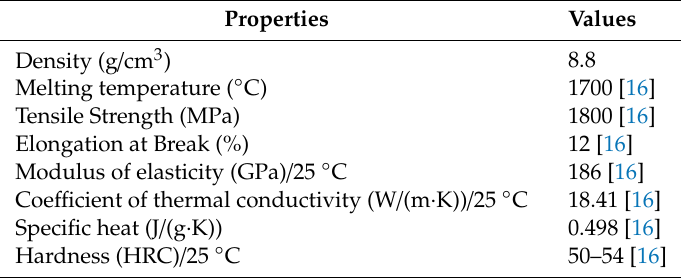
Table 2. Mechanical and thermal properties of iron–nickel based ultra-high strength